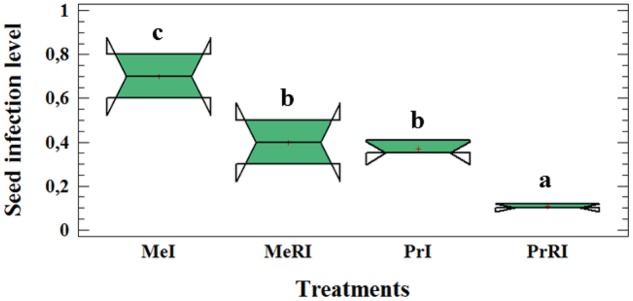
Box-and-Whisker plot (Tukey HSD test, p < 0.05, n = 12) of significant difference for seed infection severity at cultivar-microsymbiont interaction level of pea plants grown in pots. Me: CV Messire, Pr: CV Protecta, R: rhizobial, NR: non-rhizobial, I: pathogen infected, U: pathogen uninfected. Values with different letter (a, b, c) per treatment are significantly different.